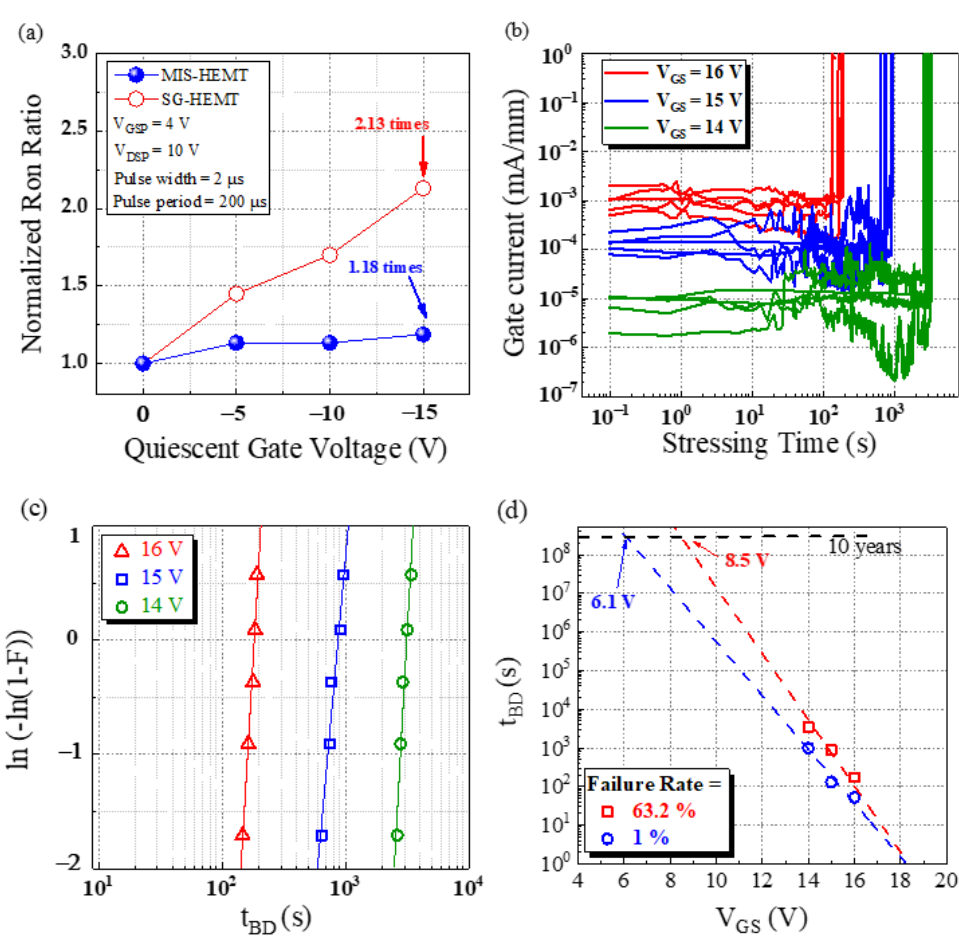
Figure 6. ( a ) Gate lag behavior and dynamic Ron, ( b ) TDDB gate current with three different gate voltages, ( c ) Weibull plot of the time-to-breakdown distributions, and ( d ) lifetime prediction with failure rate of 63.2% and 1% of MIS-HEMT.